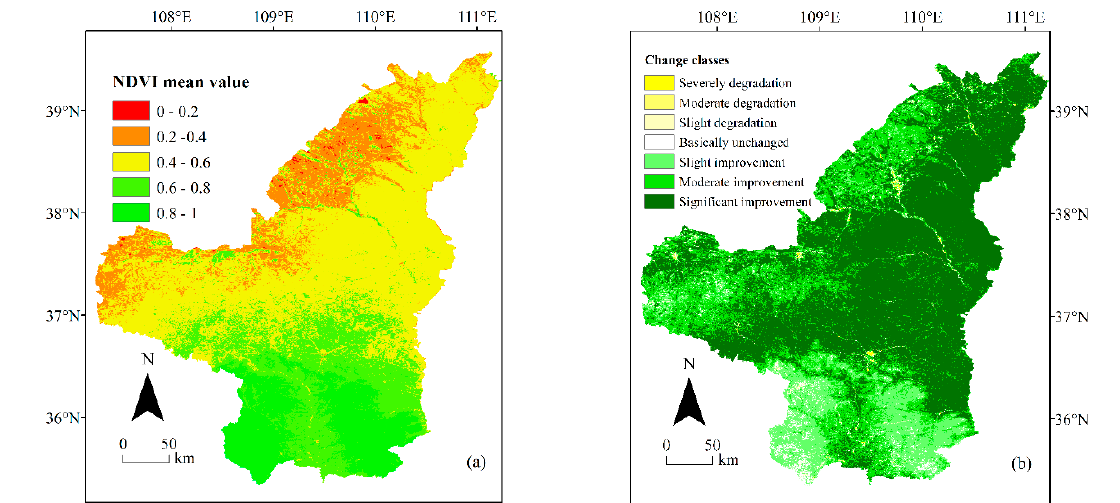
Figure 4. Spatial distribution characteristics of the mean NDVI values and changing trends in Northern Shaanxi: ( a ) the spatial distribution characteristics of the mean NDVI values in Northern Shaanxi; ( b ) the spatial distribution characteristics of the changing trends in Northern Shaanxi. Table 3. Transfer matrix of vegetation NDVI changes in 2000-2018 (unit: km 2 ).